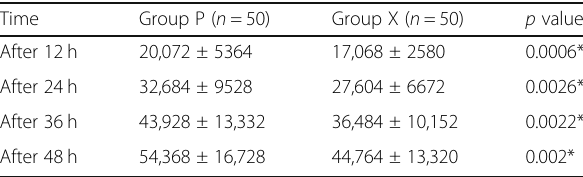
Table 6 Comparison between the two groups as regards the mean total heparin dose used